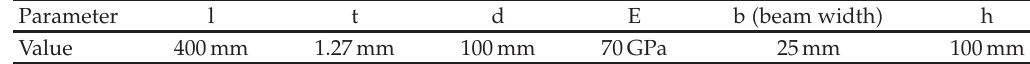
Table 1: Parameters of experimental